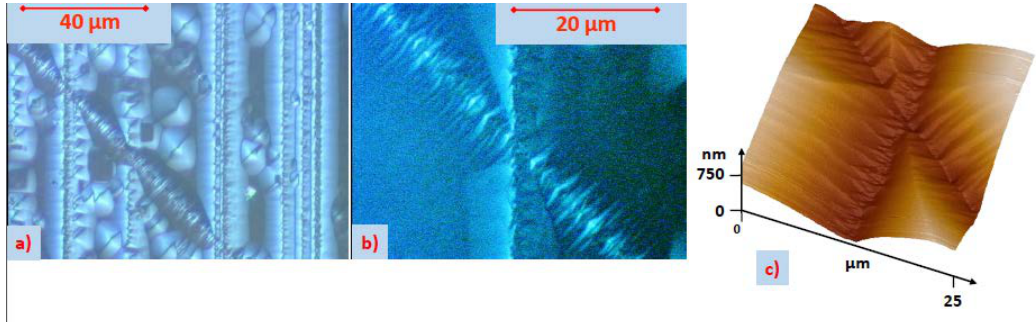
Figure 69. During plastical deformation of the SrTiO 3 crystal the bands of dislocations along <100> and <110> are independently generated ( a ). Optical photograph of the etch pits distribution in the plastically deformed region shows a perfect crossing of both bands of dislocations. Optical magnifications ( b ) and AFM topography ( c ) suggest that the dislocations along the <110> direction have a stronger tendency for bundling than for the <100> direction.